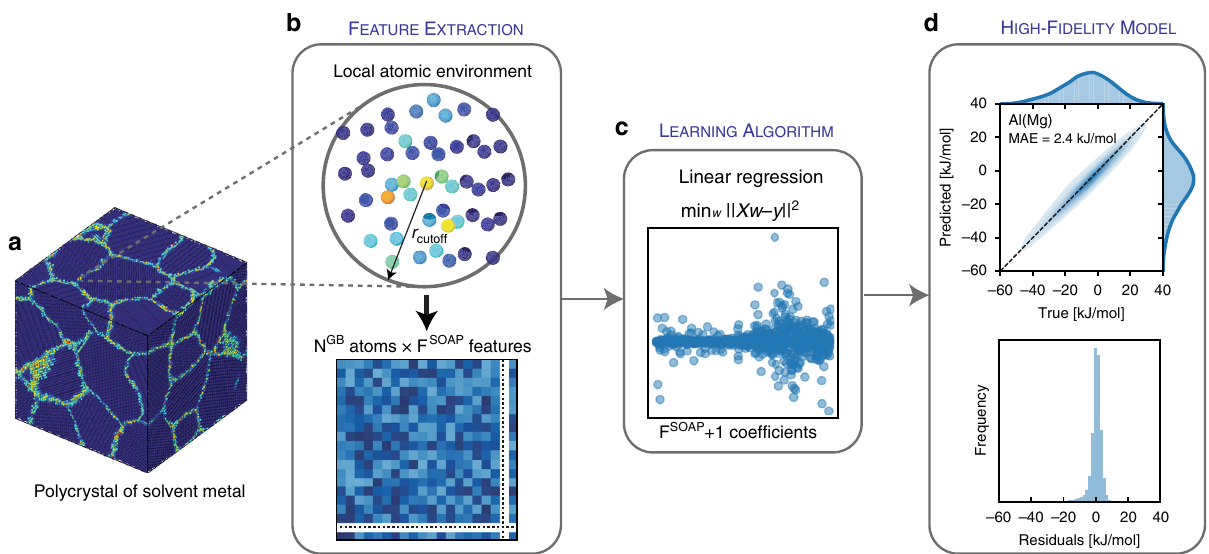
Fig. 1 High- fi delity ML model to learn Mg solute 36 segregation at GBs in an Al polycrystal. For the ( a ) 20x20x20 nm 3 thermally annealed Al polycrystal with 16 grains (colored by the centro-symmetry parameter 74 ), ( b ) the LAE of every identi fi ed GB atom is transformed into a feature vector, using the SOAP method 30 with r cutoff = 6 Å, to construct a feature matrix for the full GB network (N GB atoms x F SOAP features), which is used as the input to the ( c ) learning algorithm (linear regression) to learn Mg GB segregation energies, using a 50/50 training/testing split. d Predictive performance — mean absolute error (MAE) — of the trained ML model across the full GB